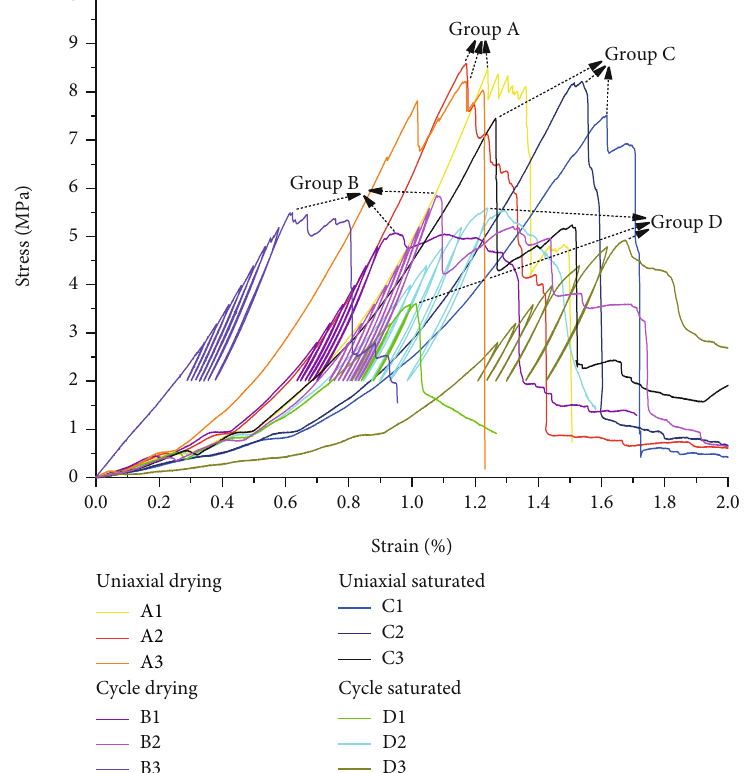
Figure 7: Stress-strain curve of deep coal samples.